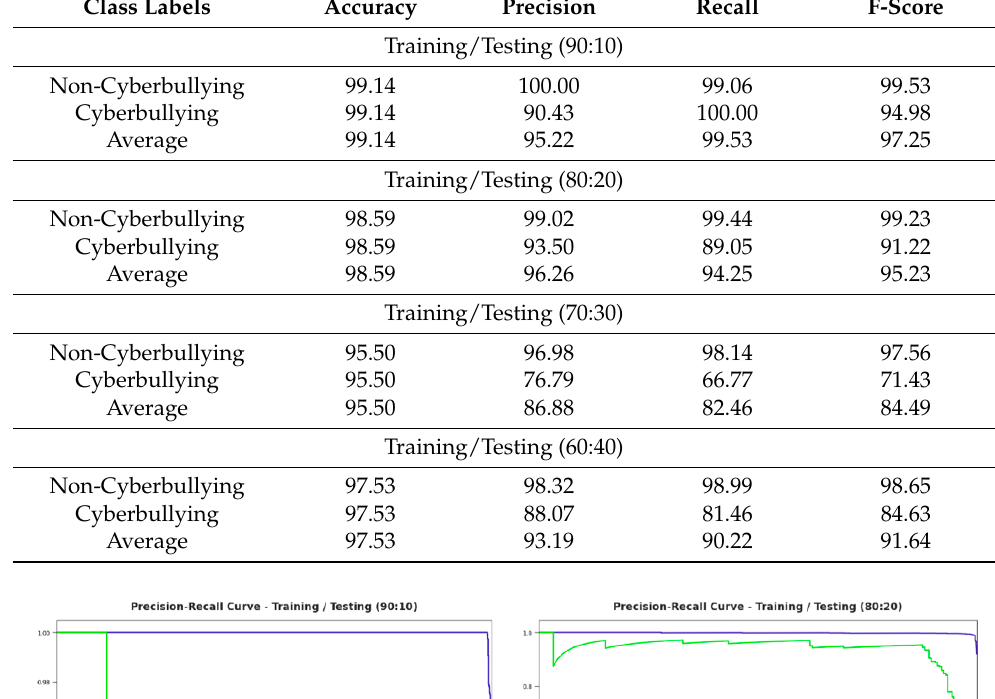
Table 2. Results of the proposed model with different measures and training/testing datasets sizes.